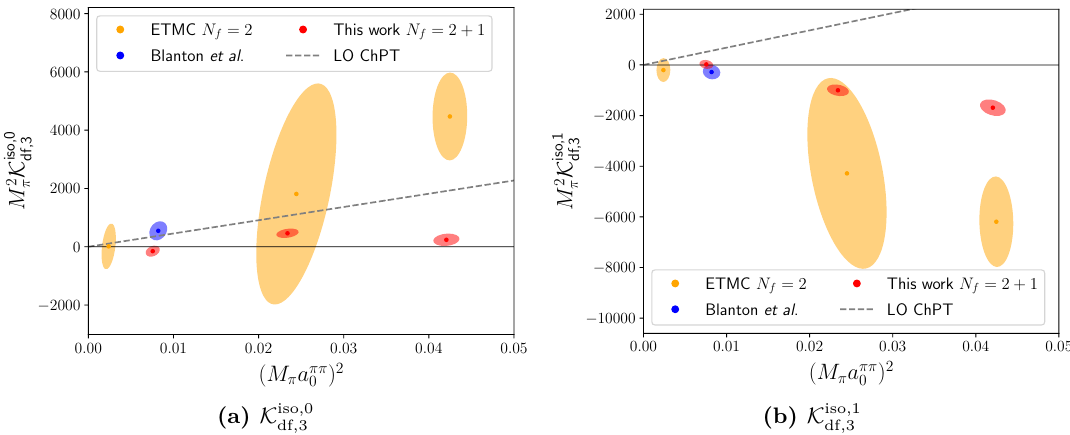
Figure 8. Three-particle scattering quantities from fits using the RFT formalism, and the s - wave-only parametrization. For our work this is fit 2 in tables 4 to 6. Results for refs. [3, 6] are also